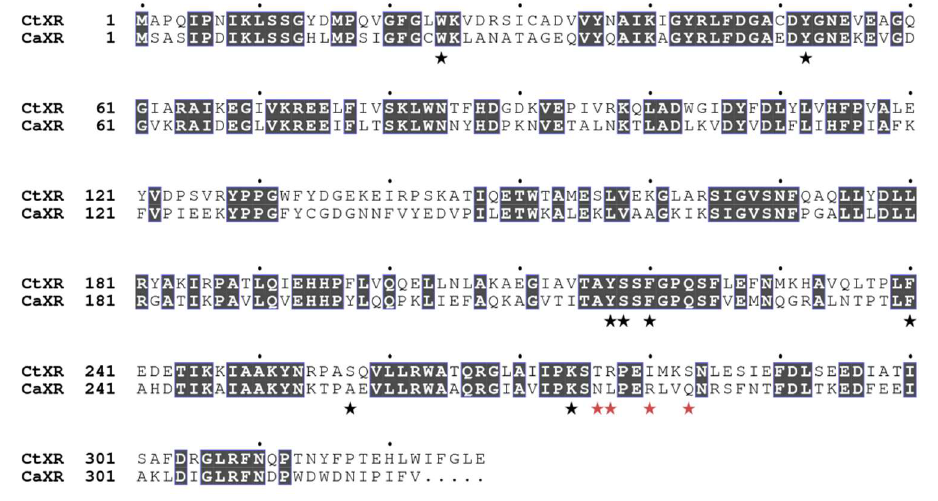
Figure 8. Sequence alignment for Ct XR and Ca XR (UniProt O74237). Shaded boxes represent identities. Black asterisks are residues highlighted in Figure 9 and red asterisks represent notable amino-acid replacements in the loop involved in binding the adenosine moiety of the